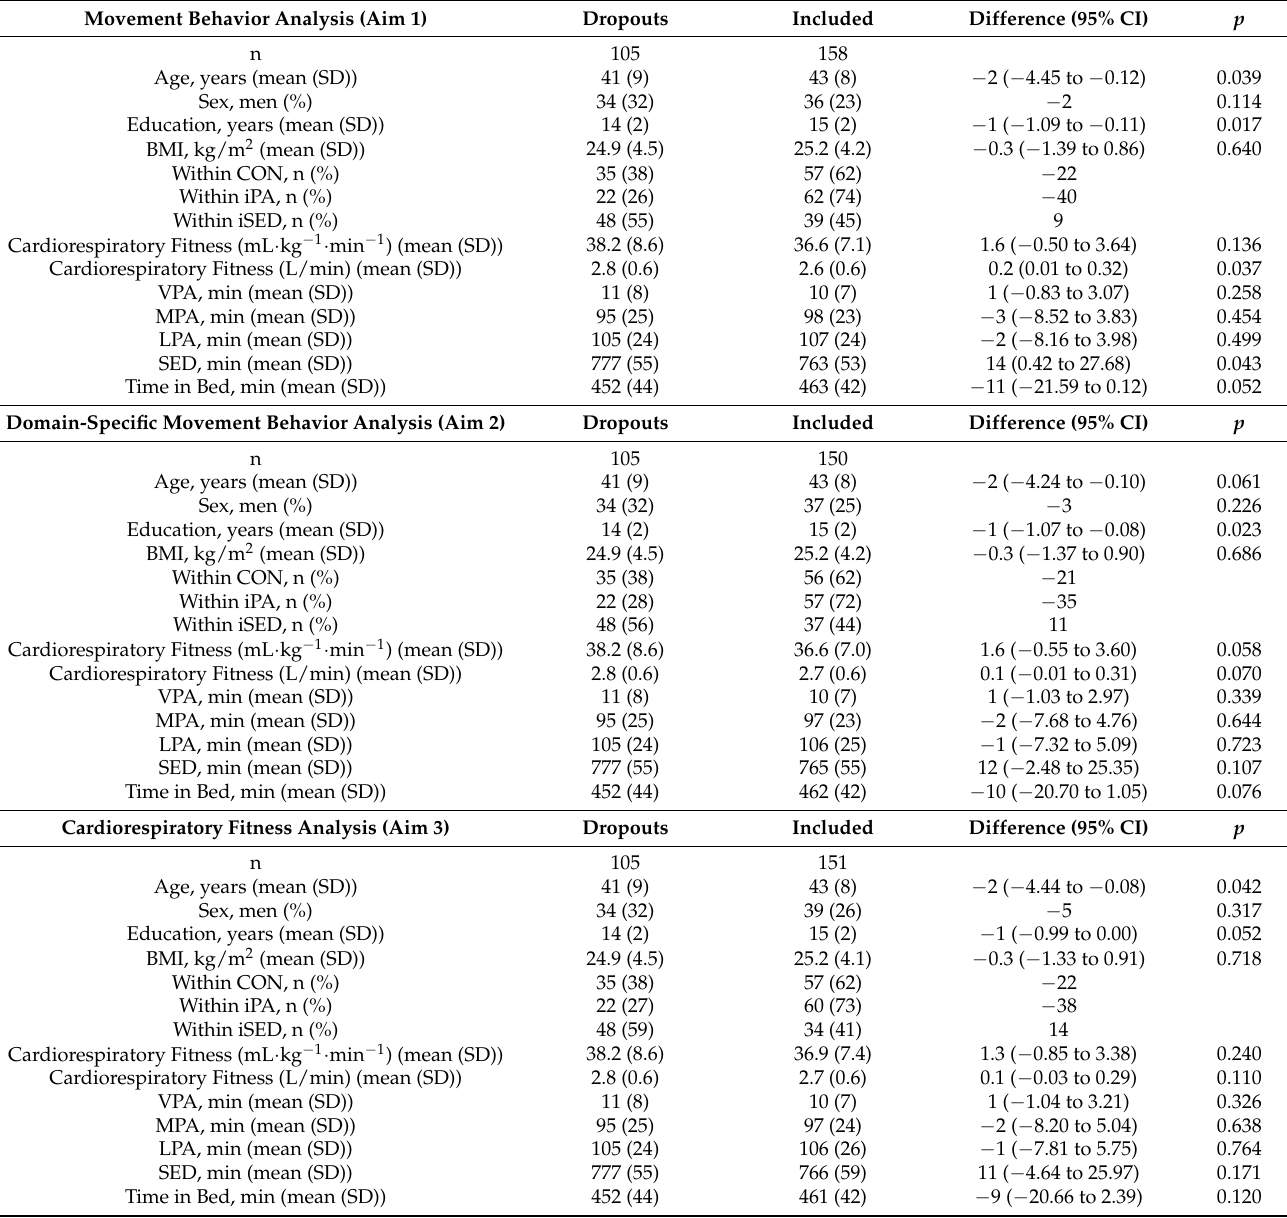
Table 7. Baseline characteristics of participants included in the three analytic samples compared to participants dropping